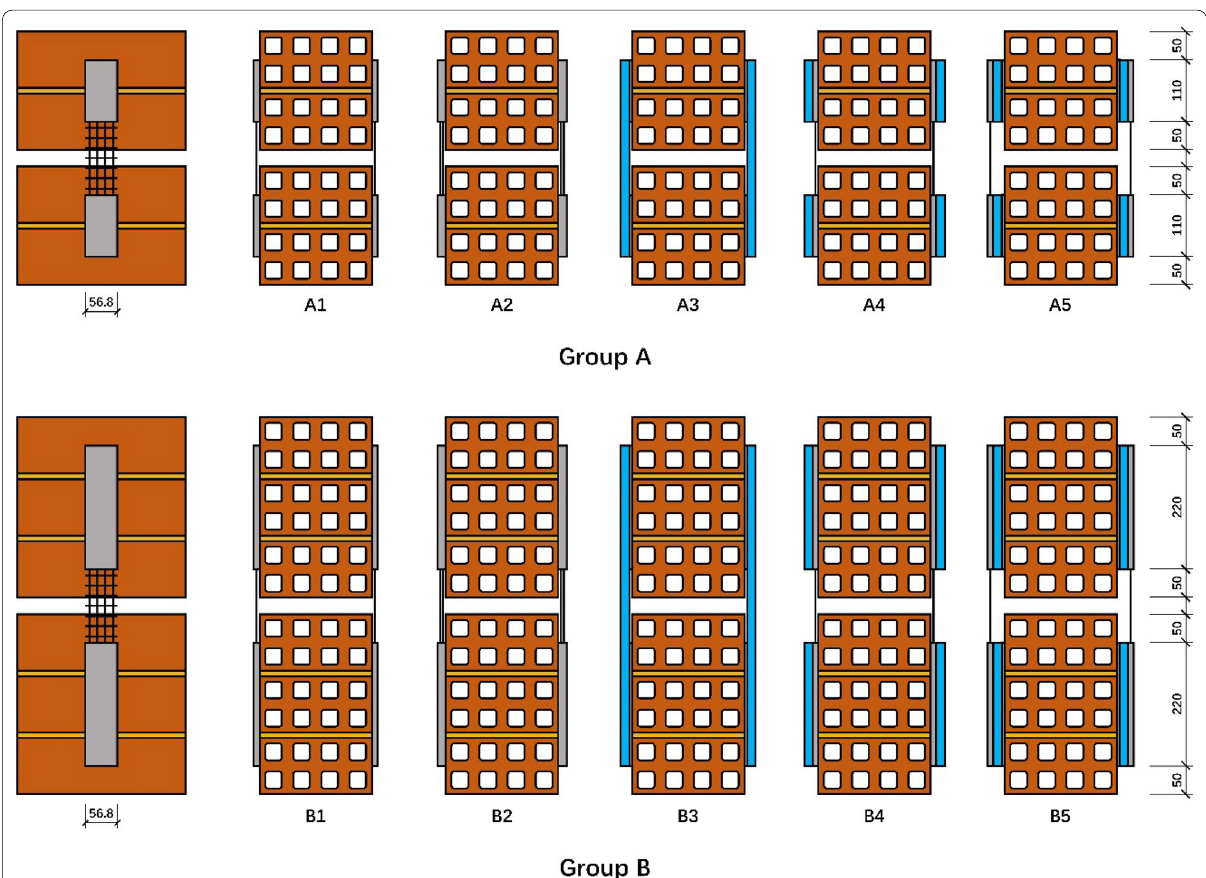
Fig. 5 Geometry of shear bond test specimens [dimensions in